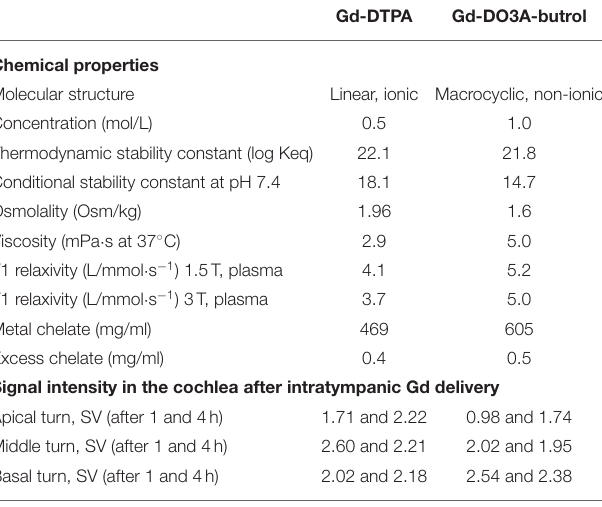
TABLE 1 | Properties of the two gadolinium contrast agents used in this study.